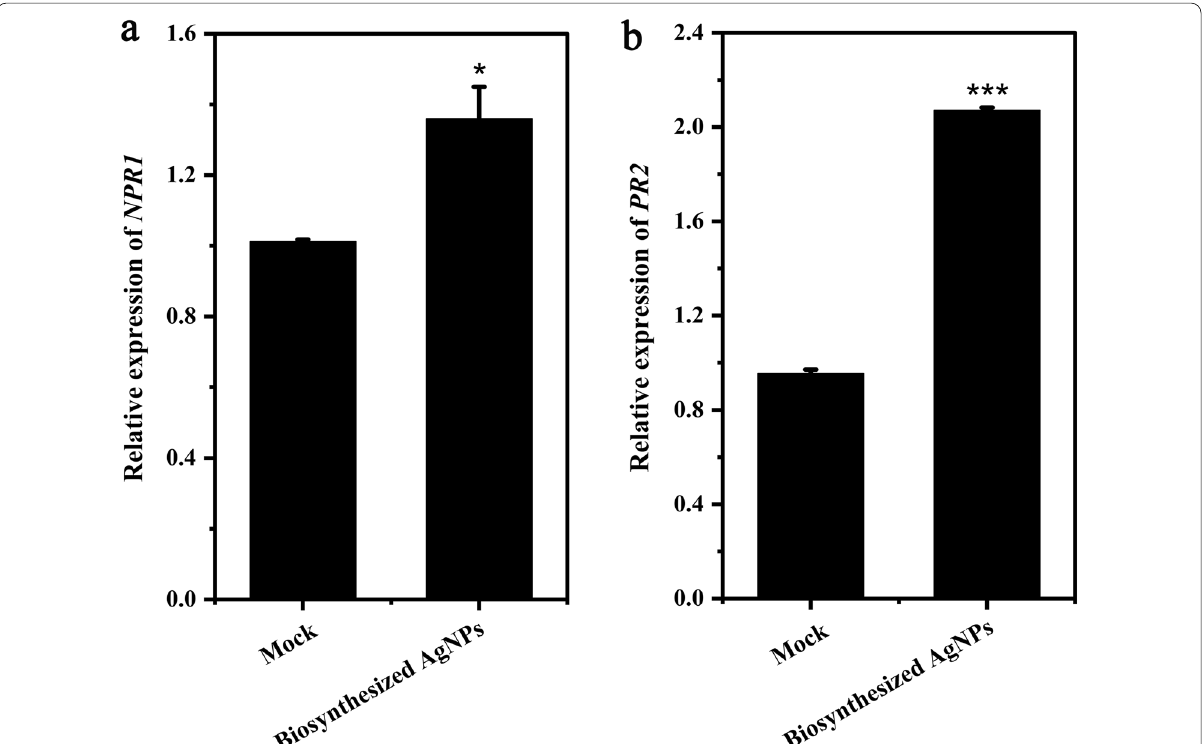
Fig. 5 Biosynthesized AgNPs induce the expression of salicylic acid (SA) signaling pathway-related genes NPR1 and PR2 in Nicotiana benthamiana . a Relative expression level of NPR1 after biosynthesized AgNPs treatment. b Relative expression level of PR2 after biosynthesized AgNPs treatment. N. benthamiana plants were sprayed with 1.2 μg/mL biosynthesized AgNPs for 3 times (once per day). Leaf samples were collected at next day after treatment. Mock, negative control (treated with sterilized distilled water). The data are mean using Student’s t test ( ∗ 0.01 < P < 0.05, ∗∗∗ P <